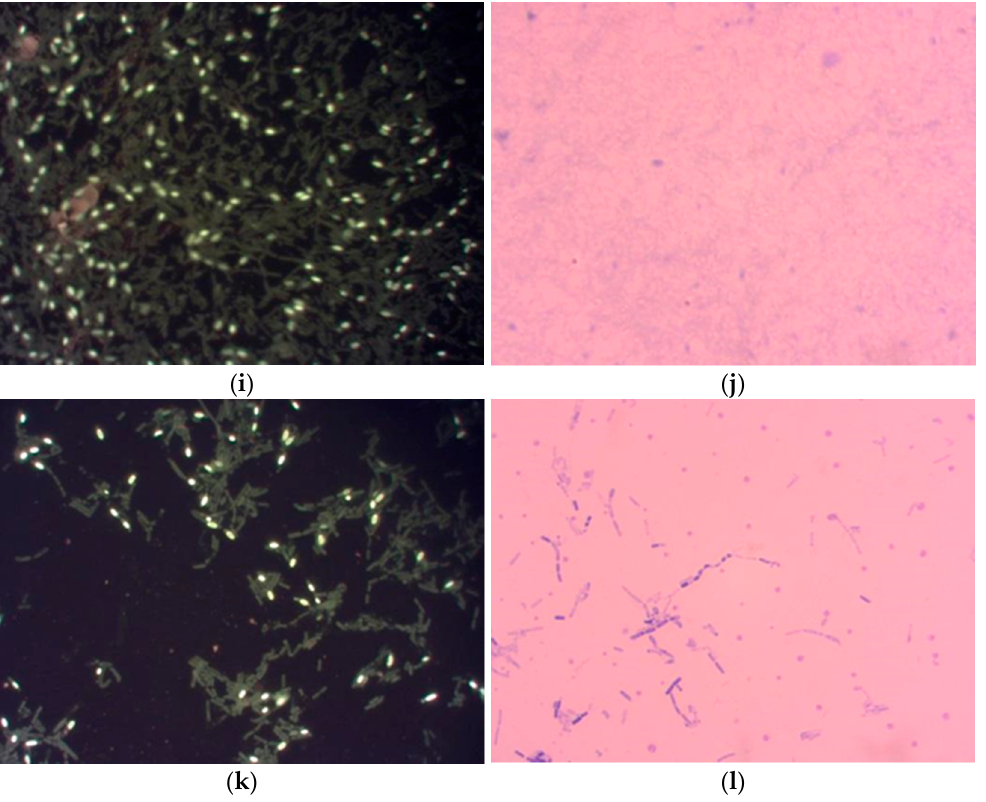
Figure 1. Bacterial morphology of Bacillus cereus , assessed with fluorescence and Gram staining. ( a , c , e , g , i ) fluorescent staining of the bacterial morphology at 0.75, 0.375, 0.188, 0.094, and 0.047 ppm NaOCL concentrations, respectively. ( b , d , f , h , j) Gram staining of the bacterial morphology at 0.75, 0.375, 0.188, 0.094, and 0.047 ppm NaOCL concentrations, respectively. ( k ) Fluorescent staining of the bacterial morphology using water. ( l ) Gram staining of the bacterial morphology using water. Table 2. Distribution of the decrease in the number of bacteria by treatment